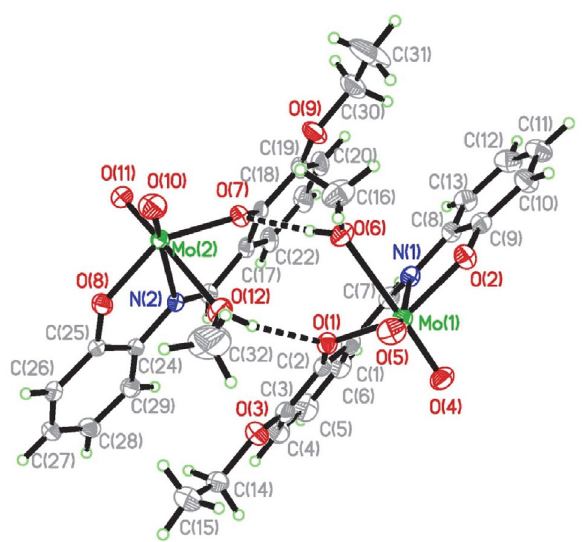
Figure 3. A perspective view of complex 2 with the atom labeling scheme. Thermal ellipsoids are drawn at the 30% probability level. Hydrogen bonds are shown as dashed